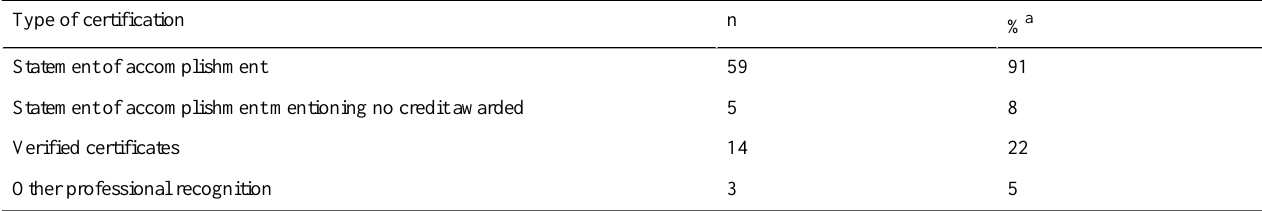
Table 7. Certification types on MOOC descriptions.